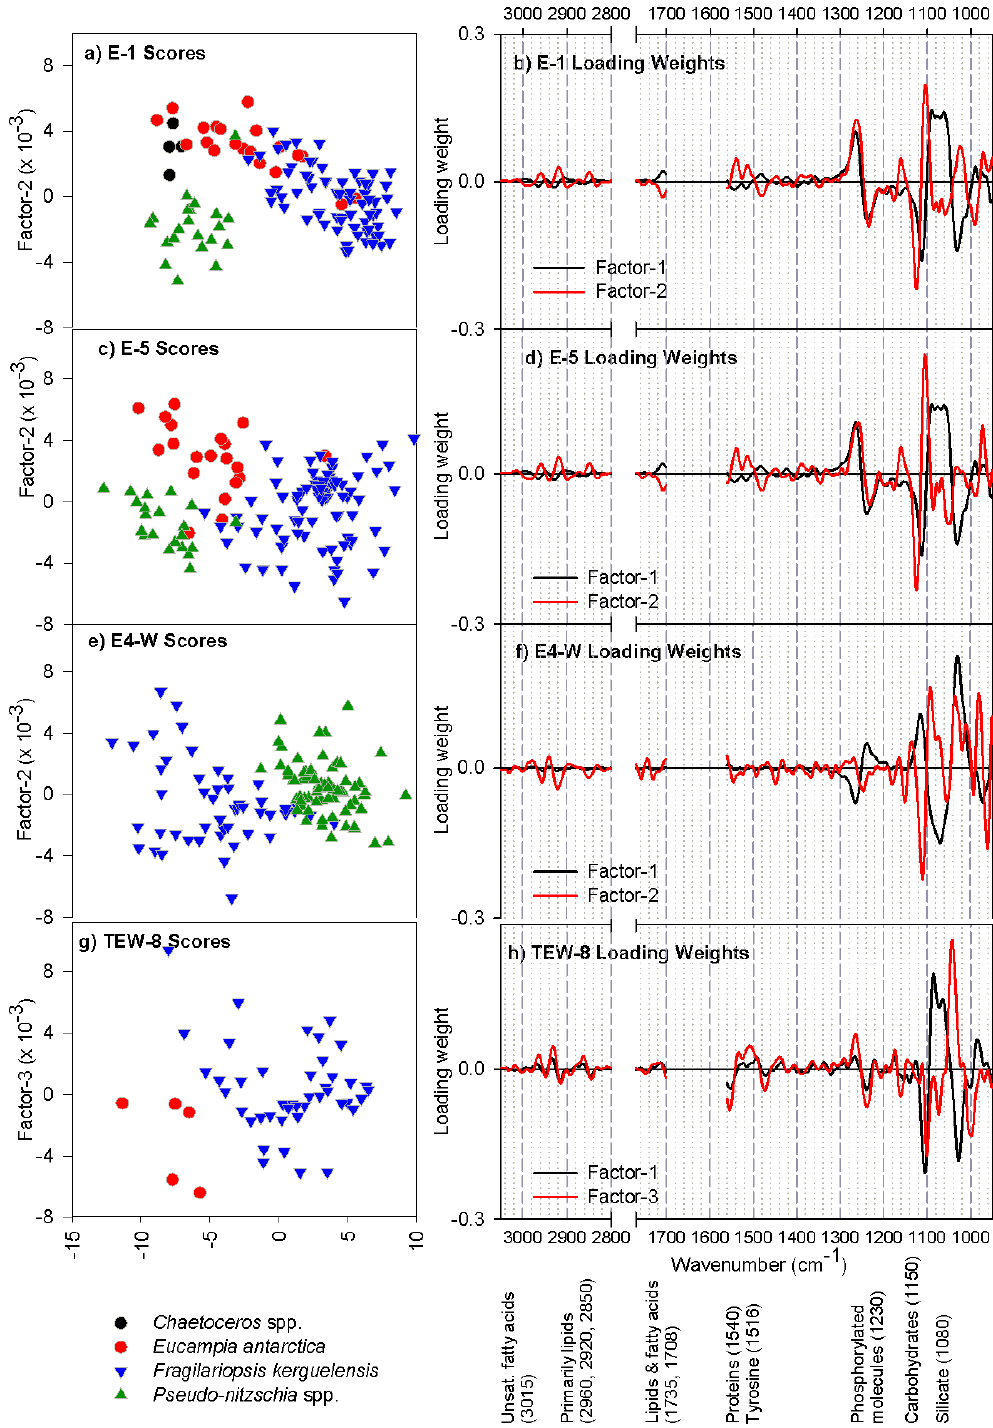
Figure 3. Taxonomic classification by PLSDA results for four common genera: Chaetoceros spp, Eucampia antarctica , Fragilariopsis kerguelensis and Pseudo-nitzschia spp. Panels (a–h) show four different stations. Scatter plots on the left-hand side show scores and line plots on the right-hand side show the associated loading weights. The score plots indicate that the cell spectra cluster well by taxonomic grouping at each site. The loading-weight plots indicate that the source of the variation between cell spectra is largely from the lower wavenumber region ( ∼ 1240–1000cm − 1 )